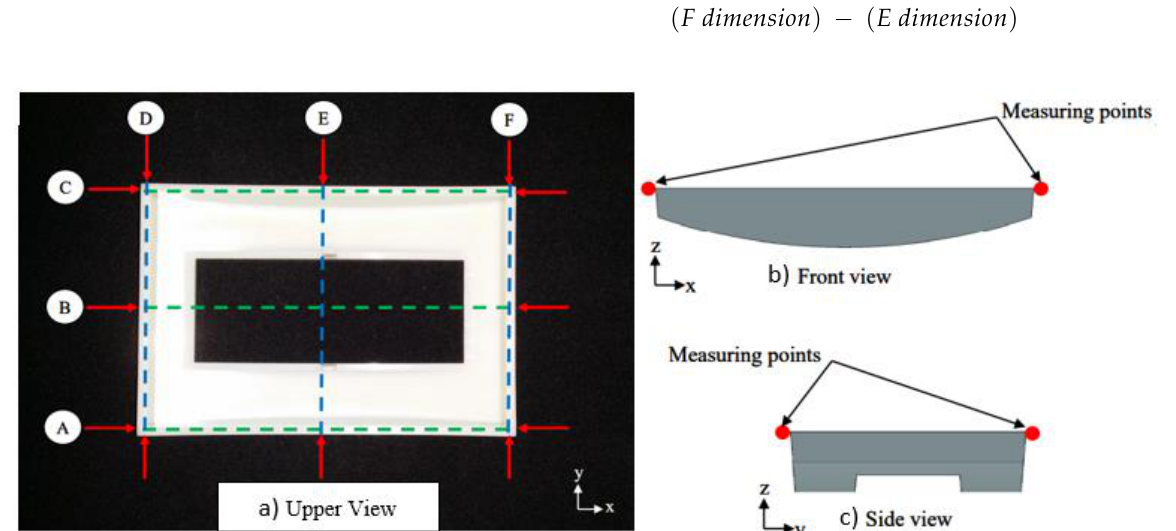
Figure 10. Moulded specimen (front panel housing) with measuring point, ( a ) upper view, ( b ) front view, ( c ) side view.